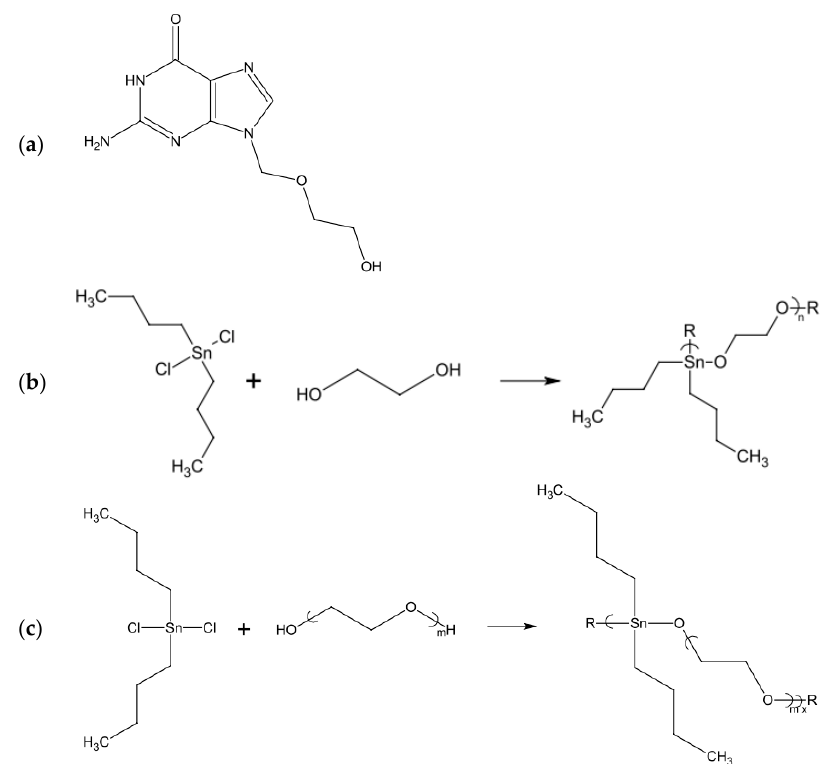
Figure 4. Some of the polymers that were tested by Frank and her group. ( a )—Structure of polymer repeat unit for the product of acyclovir and diorganotin dihalides; ( b )—Synthesis of organotin polyethers derived from dibutyltin dichloride and ethylene glycol; ( c )—Repeat unit for the product of dibutyltin dichloride and poly(ethylene glycol). Reprinted by permission from Springer, Roner MR, Carraher CE, Miller L, Mosca F, Slawek P, Haky JE, et al. Organotin Polymers as Antiviral Agents Including Inhibition of Zika and Vaccinia Viruses. J Inorg Organomet Polym Mater 2020;30:684–94. Copyright (2020) Springer [92].